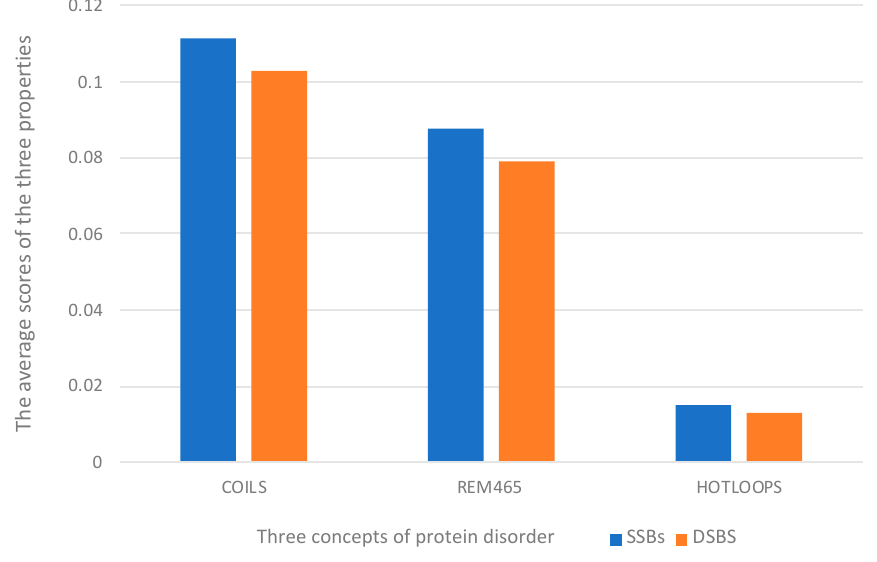
Figure 5. Average scores of DisEMBL’s three properties on SSBs and DSBs.